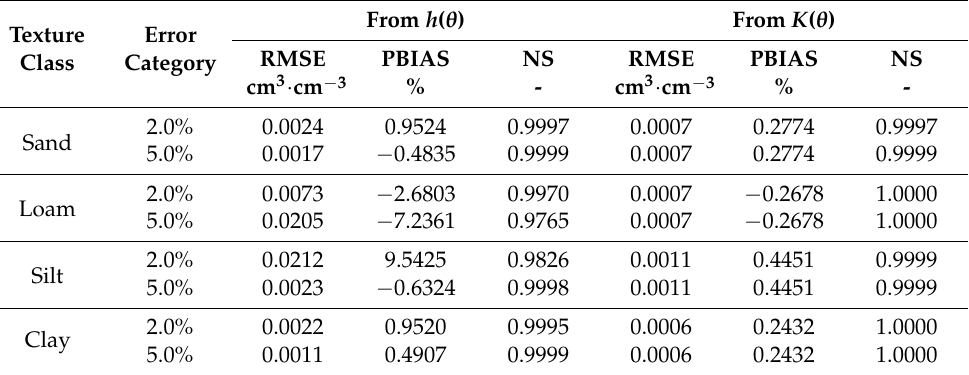
Table 8. Soil water content errors calculated from inverted SWRCs and conductivity curves with random errors in cumulative infiltration for the four typical soils.